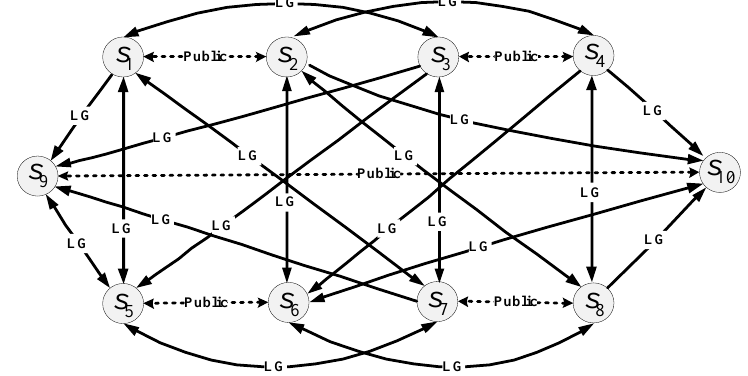
Figure 3. Integrated graph model for the brownfield dispute.